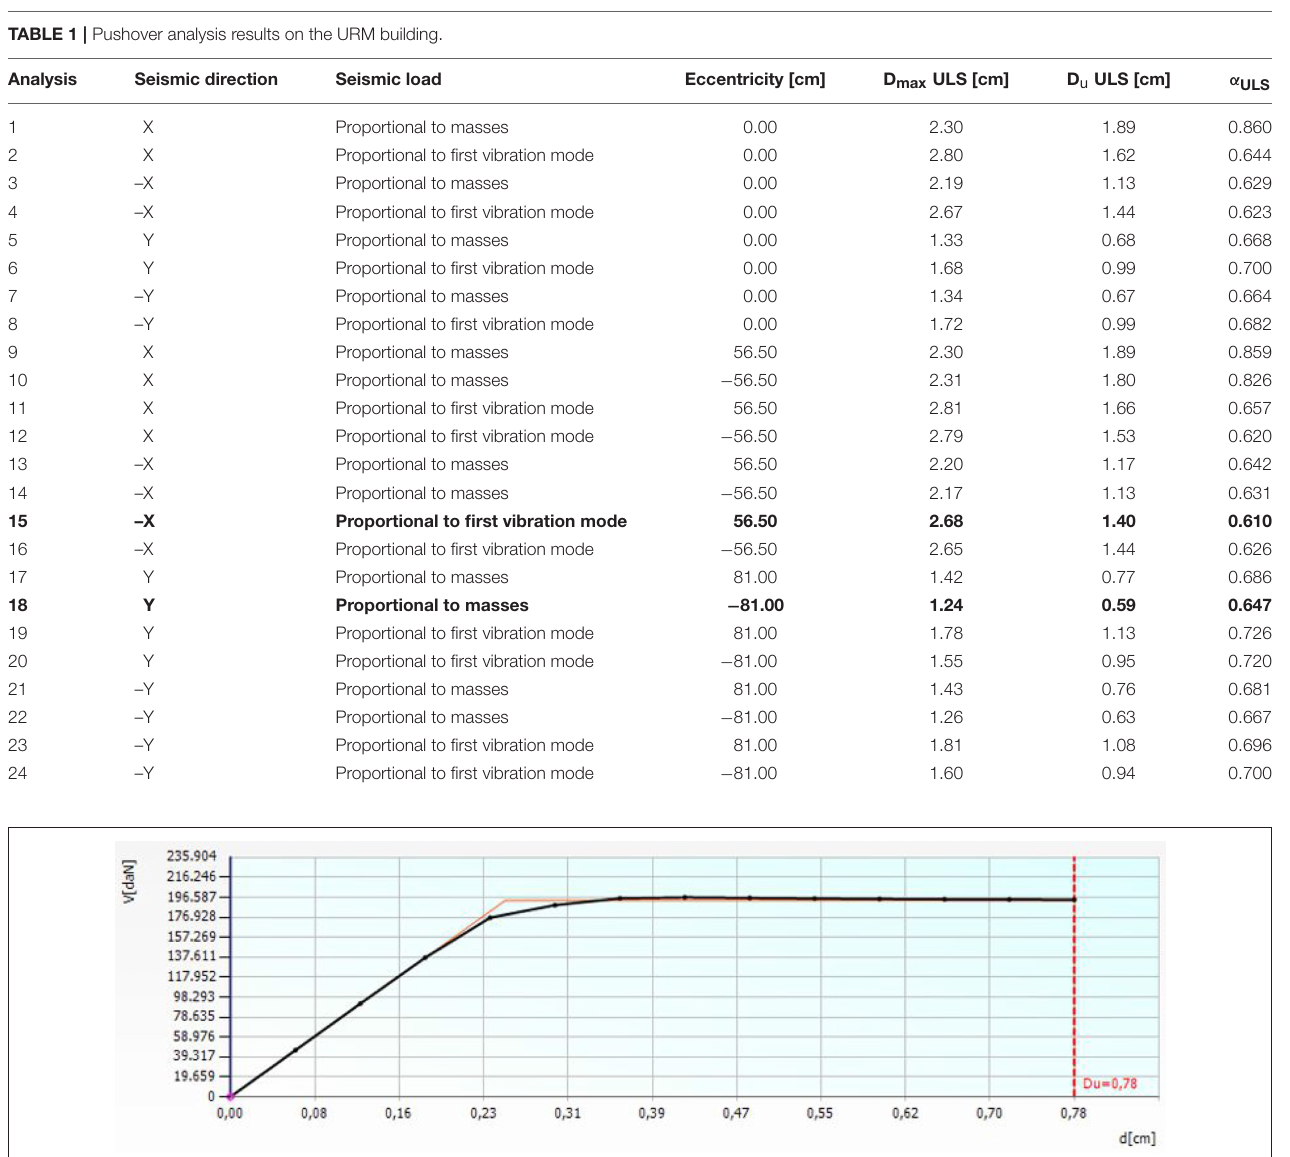
FIGURE 3 | Pushover curves resulting from analysis